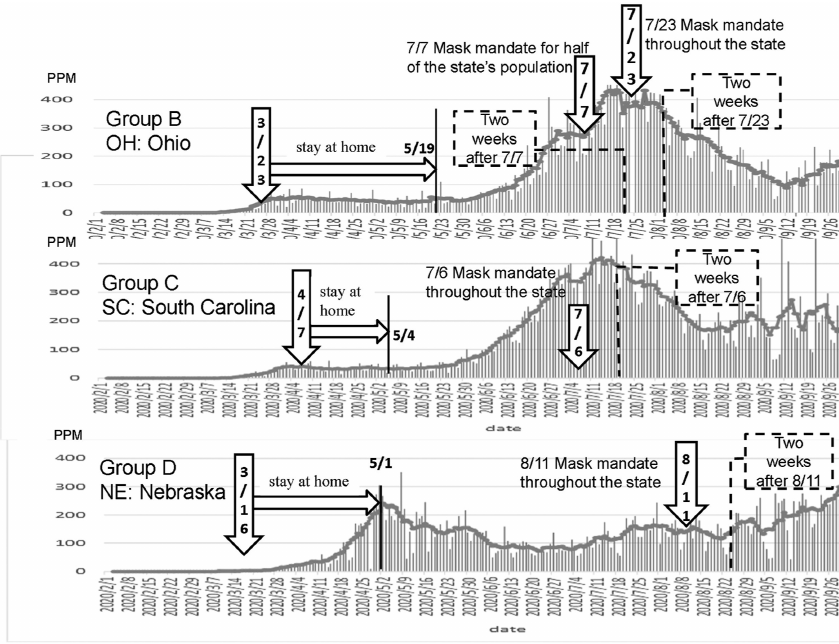
Figure 1. Time series graph of number of newly infected people in Ohio (Group B), South Carolina (Group C),